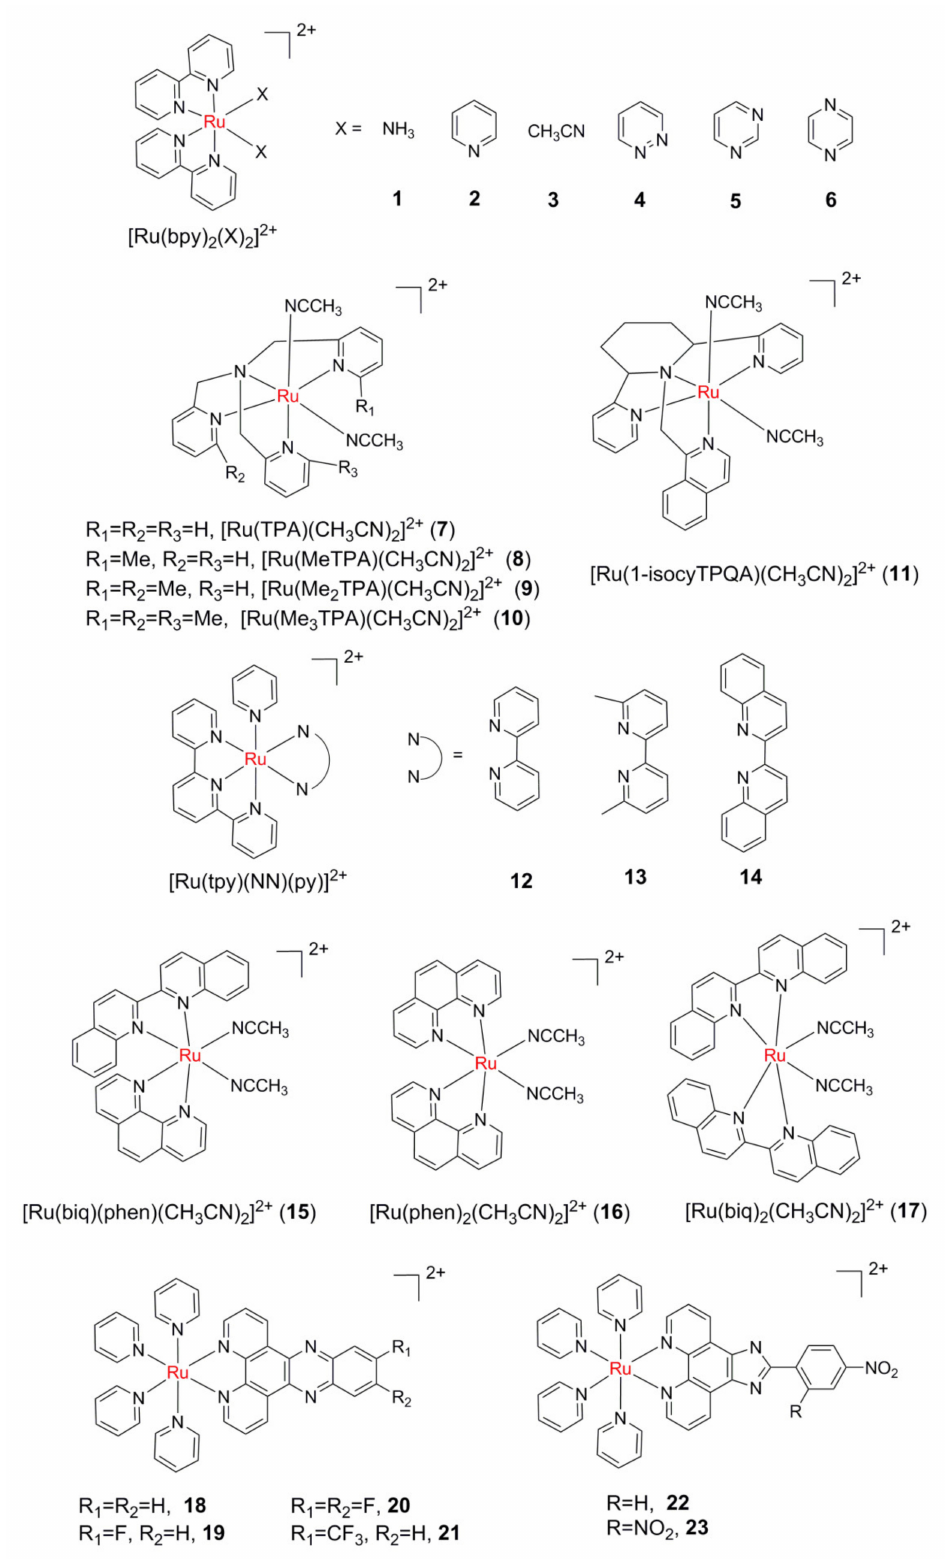
Figure 4. Ru(II) polypyridyl complexes with photolabile monodentate ligands. Glazer et al., reported three Ru(II) polypyridyl complexes 4 – 6 [54] with isomeric diazine ligands, and their photochemical properties were compared to 2 . It was found that unlike 2 , which photodissociated only one monodentate ligand in water, 4 – 6